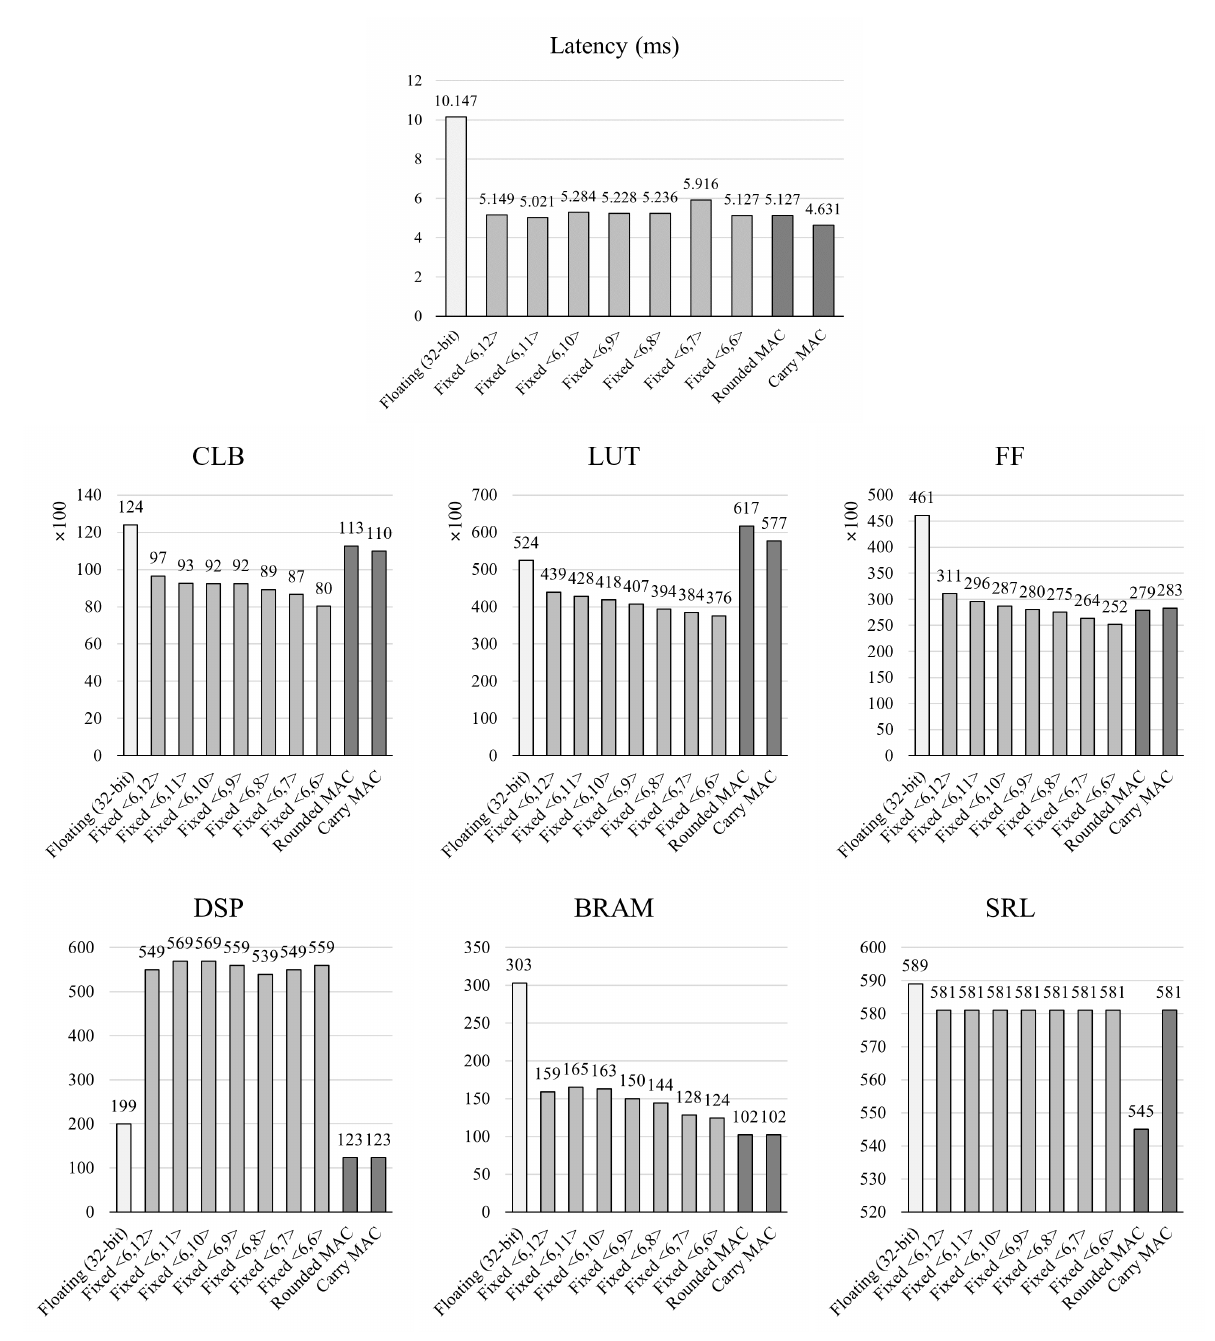
Figure 15. Comparisons of latency and resource usage between accelerator